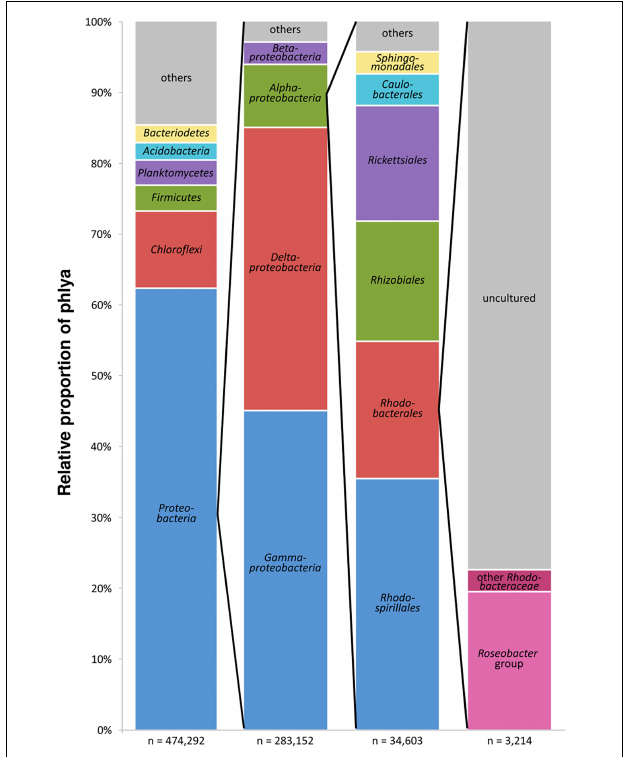
FIGURE 2 | Composition of the benthic, metabolically active microbial community based on bacterial 16S rRNA transcripts in the entire dataset displayed in the different phylogenetic levels ( n = sum of sequences in the respective phylogenetic level, “others” includes all phyla < 2%).